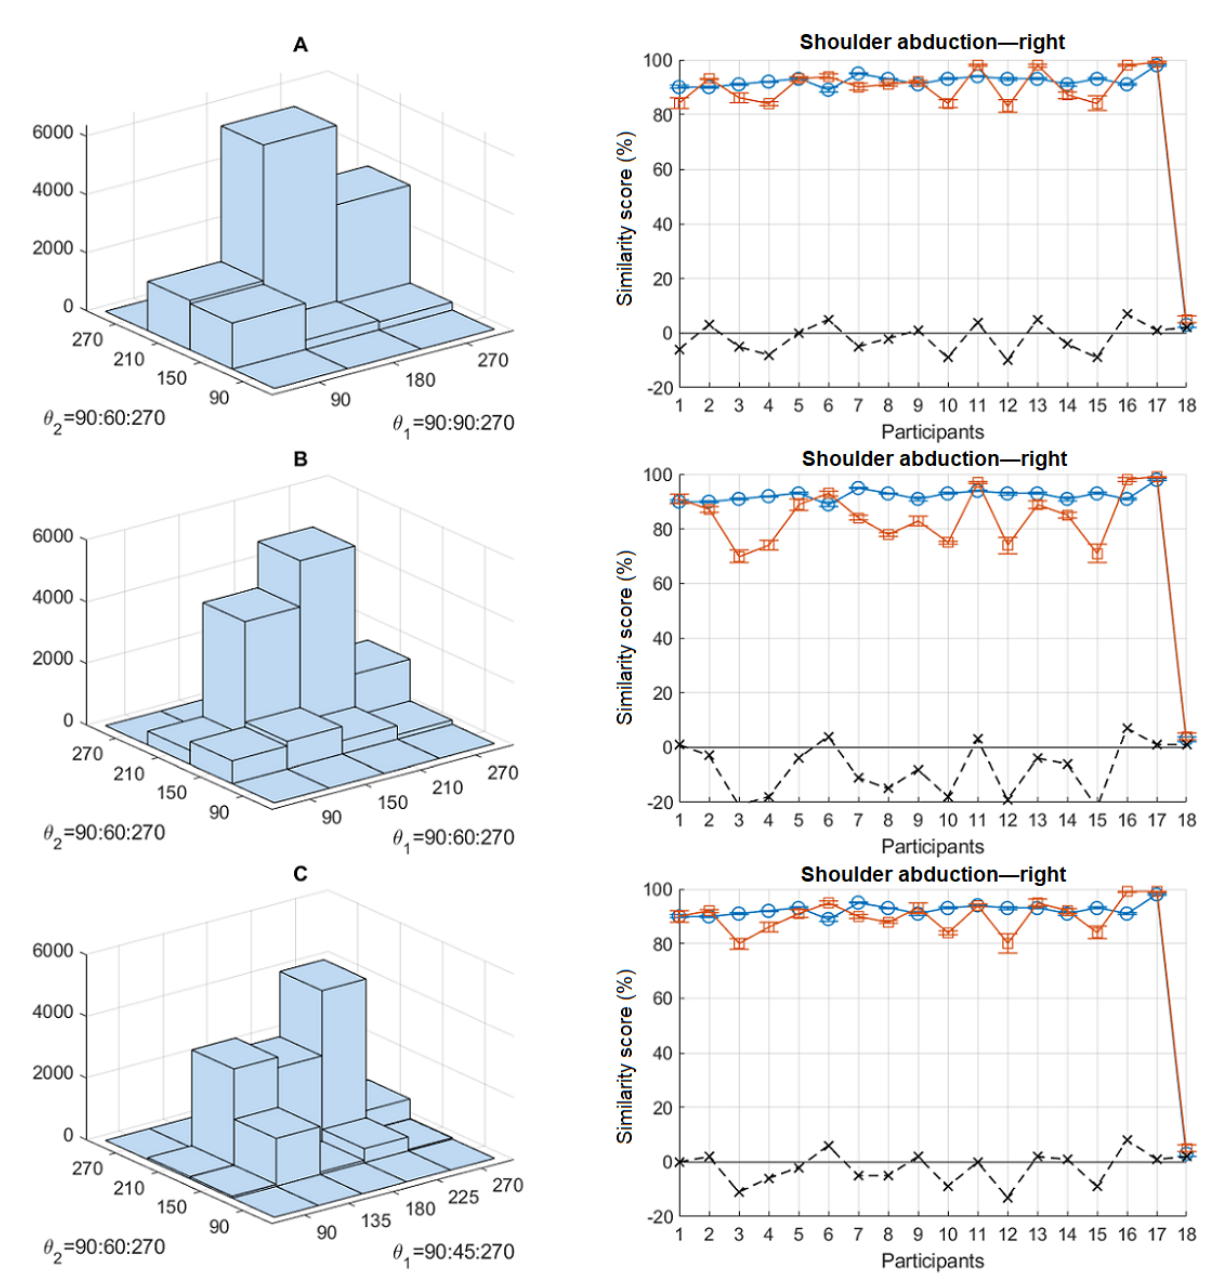
Figure 9. The effect of quantization on the calculated hidden Markov model